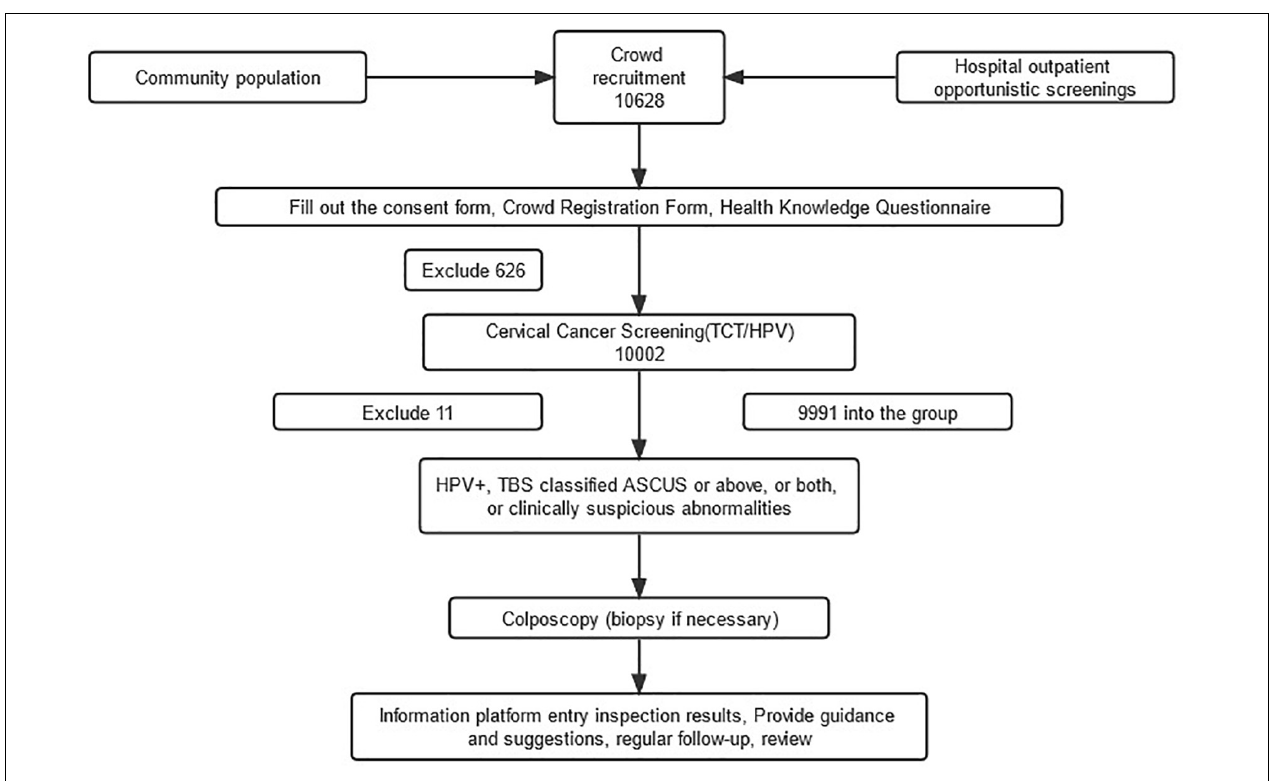
FIGURE 1 | The CONSORT flow of